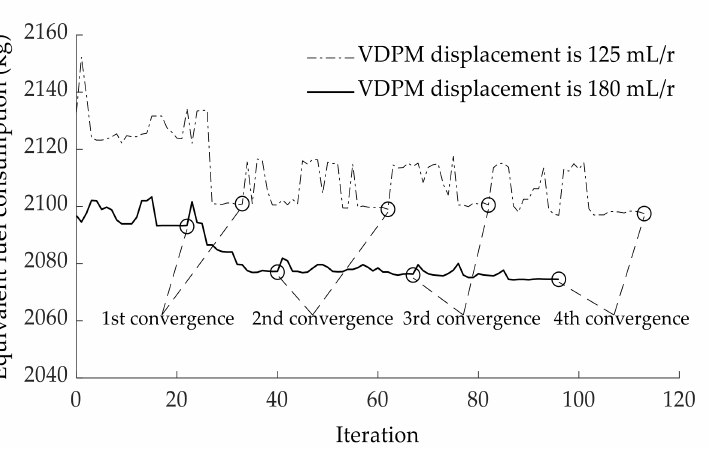
Figure 15. Variation of equivalent fuel